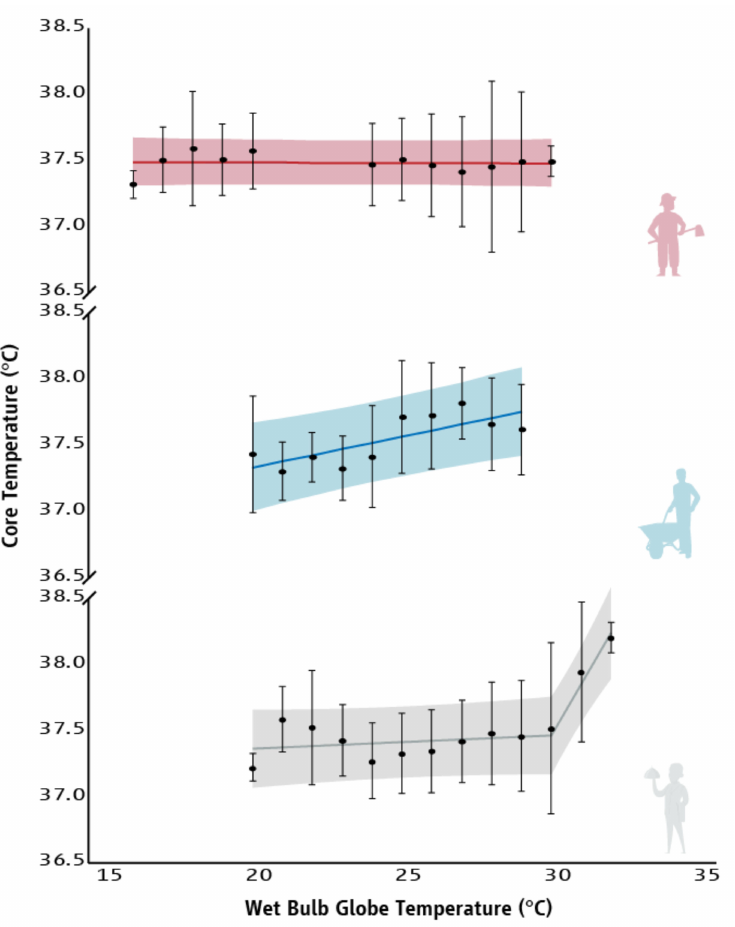
Figure 3. Relationship between Wet-Bulb Globe Temperature and the core temperature (aver- age ± SD) of people who work in agriculture (red), construction (blue), and tourism (grey) sectors. Lines represent the slope of the predicted relationship between Wet-Bulb Globe Temperature and the core temperature of workers. Shadings correspond to the 95% prediction intervals of the